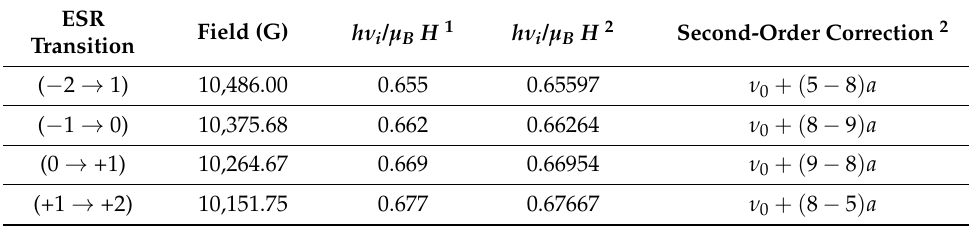
Table 2. Second-order corrections for J = 2 1 O 2 ( 1 ∆ g) spectrum of the X band ESR signals. ESR